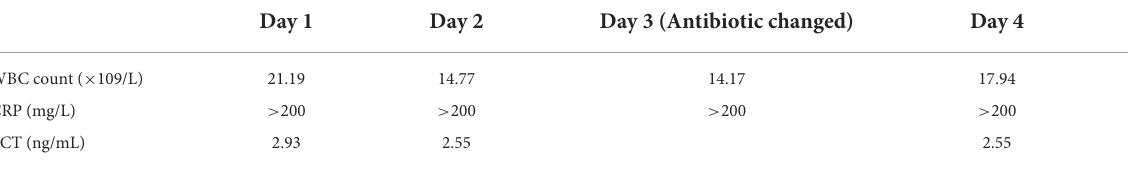
staining depends on the operator’s experience. At this point, the strain was identified as P. micra using the Zhongyuan (Figure 1F). It took 1 week to finally identify the bacteria from the time the blood culture specimens were sent to